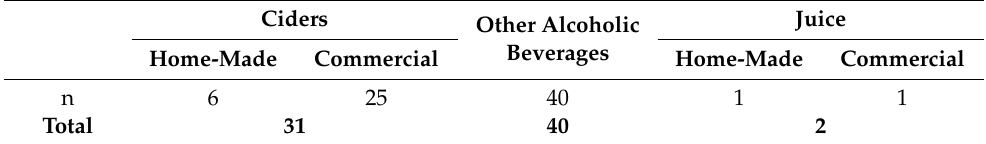
Table 2. Characteristics of tested set of samples.